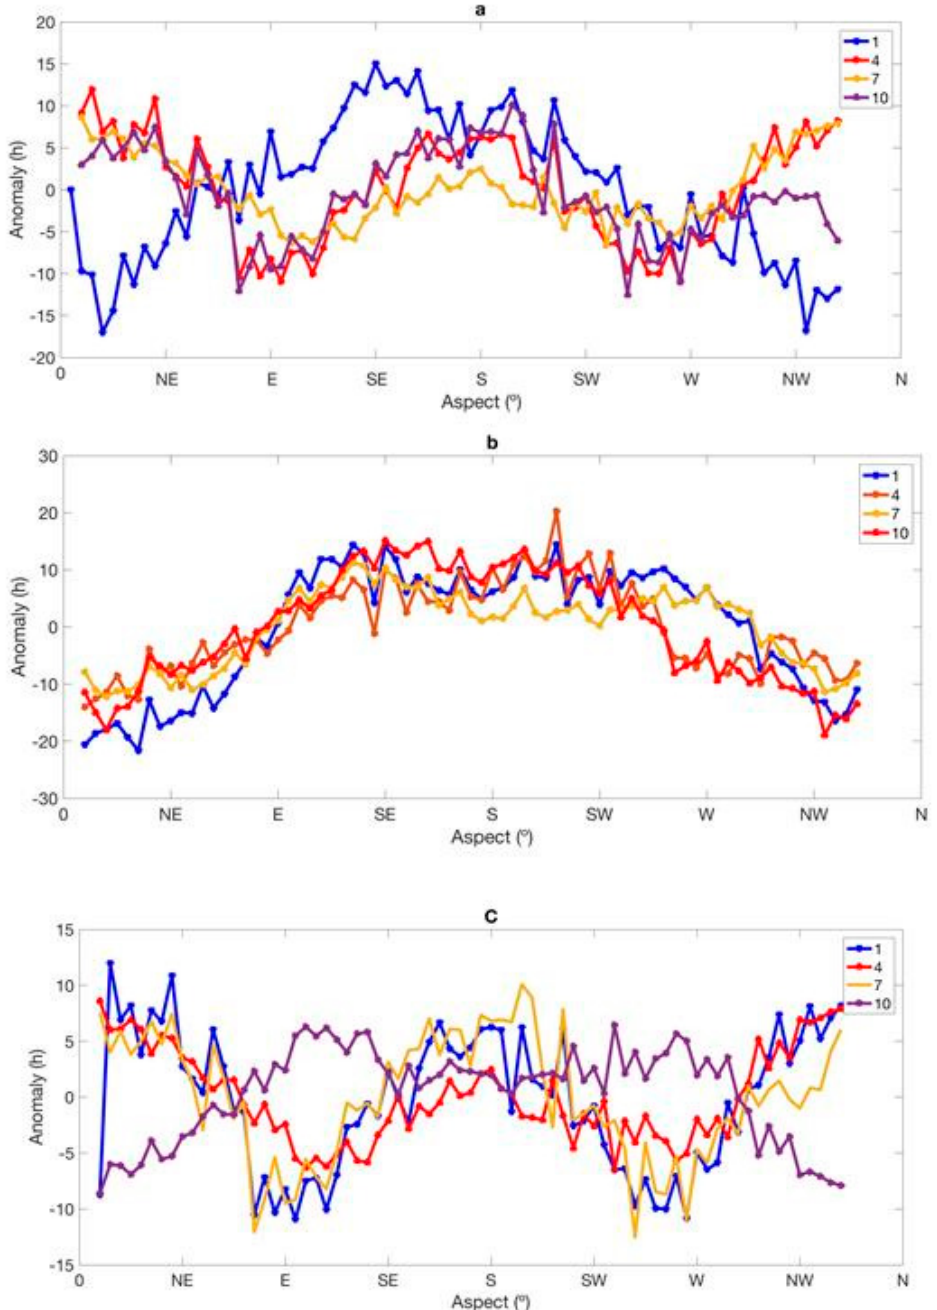
Figure 4. Anomaly curves with respect to slope direction of ( a ) maximum possible sunshine duration (MSPD), ( b ) SD and ( c ) SSP, for 1 January, 4 April, 7 July and 10 October 2010.